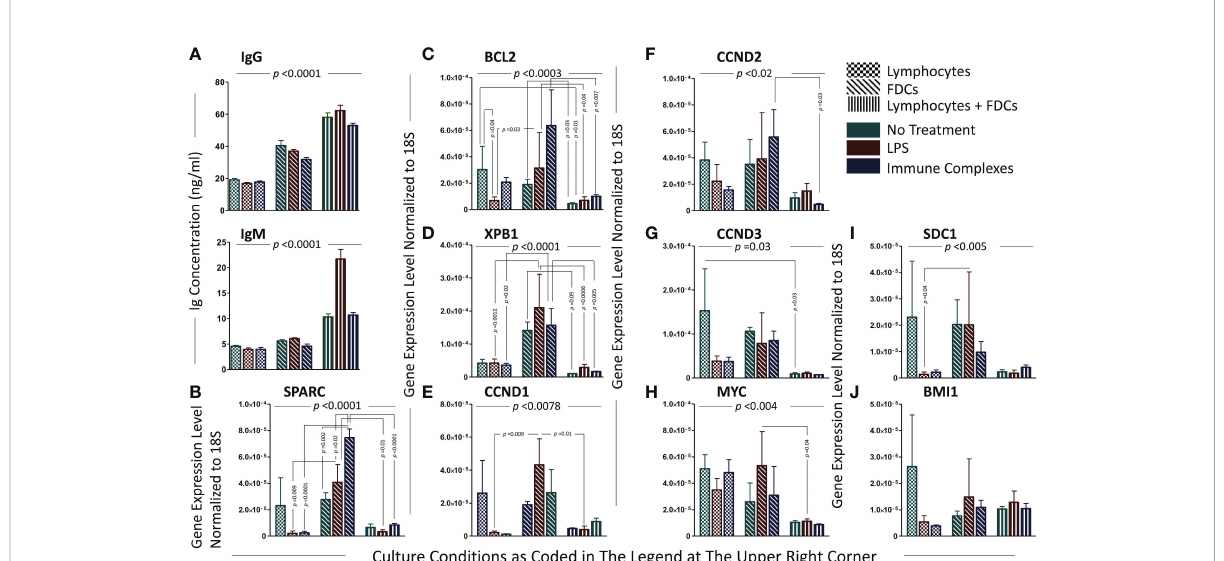
FIGURE 7 Analysis of plasma cell-associated genes and immunoglobulin secretion in the in vitro GCRs of SLTs. The levels of immunoglobulins secreted by PCs in the cell cultures of the in vitro GCRs among the different experimental conditions (evidence of B-cell activation and differentiation into PCs with antibody secretion); immunoglobulin IgG and IgM ELISA assays, respectively (A) . Data are presented as mean ± SEM, p-value <0.0001. Signi fi cant difference between the nine experimental conditions of the in vitro GCR cell cultures were detected using Kruskal – Wallis test with Dunn ’ s multiple-comparison correction in both assays. Each gene relatively expressed to 18S on lymphocytes, FDCs, and FDCs + lymphocytes in three experimental conditions (untreated, stimulated with LPS/ICs) (B – J) . Data are presented as mean ± SEM. Two-way ANOVA with Tukey ’ s posttest was used to compare the change in gene expression among the three types of cell culture under different treatments, and signi fi cant results were presented across the top of the graphs. Comparisons were then run between comparable conditions, and the signi fi cant differences were also